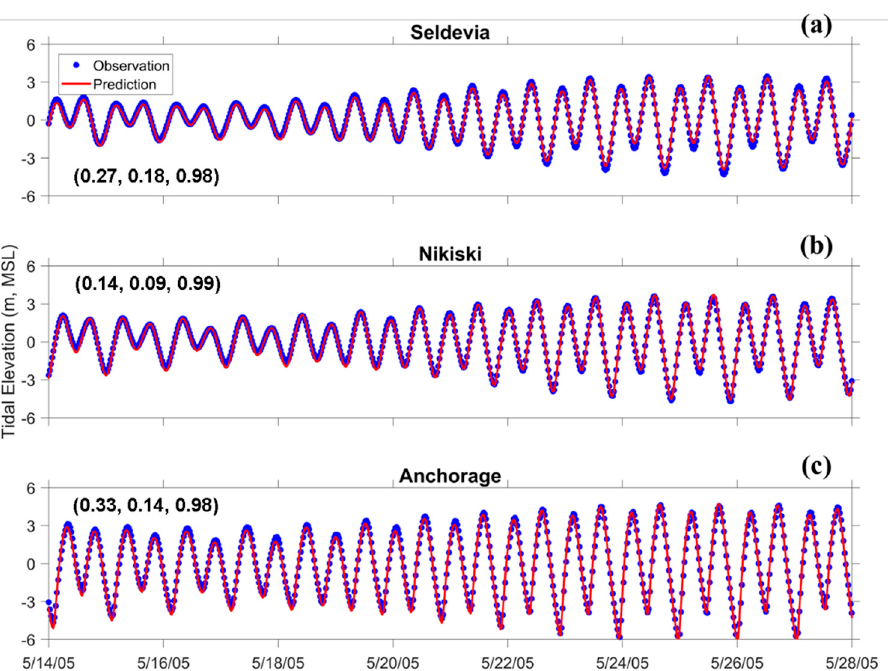
Figure 2. Time-series comparisons of model-predicted tidal elevations and National Oceanic and Atmospheric Administration (NOAA) observations at three tidal gages inside Cook Inlet, ( a ) Seldevia, ( b ) Nikiski, and ( c ) Anchorage. The numbers inside the brackets are root-mean-square-error (RMSE), scattered index (SI), and coefficient of determination (R 2 ) values.